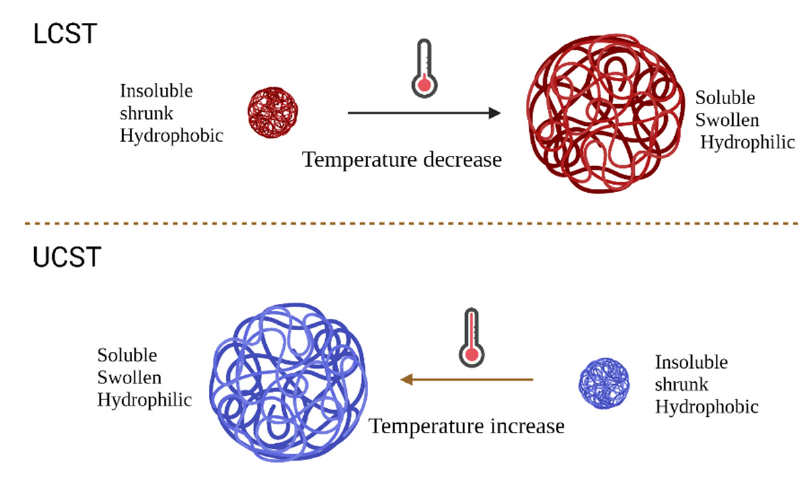
Figure 6. A schematic representation of LCST and UCST concepts and the polymer properties. Cre- ated in Biorender.com, accessed date (02/09/2022).